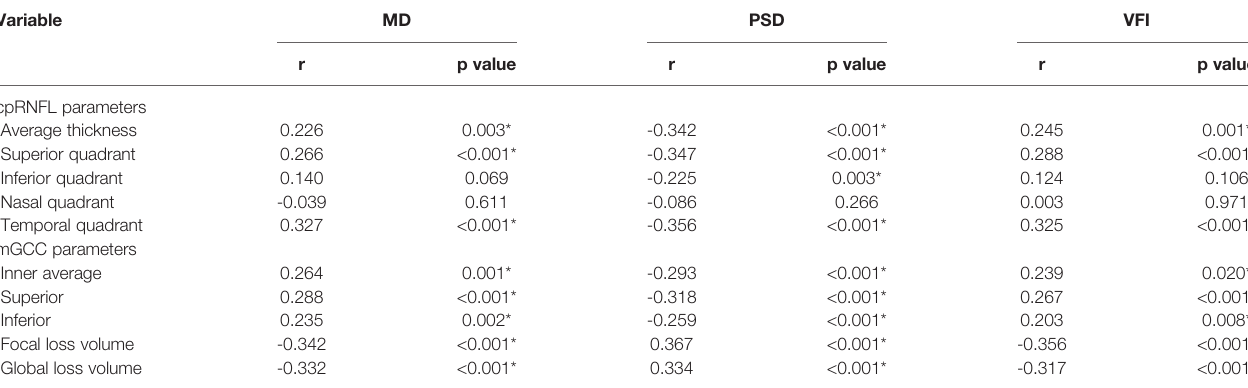
TABLE 2 | Relationship between GCC parameters, RNFL thickness parameters, and preoperative visual fi eld parameters.